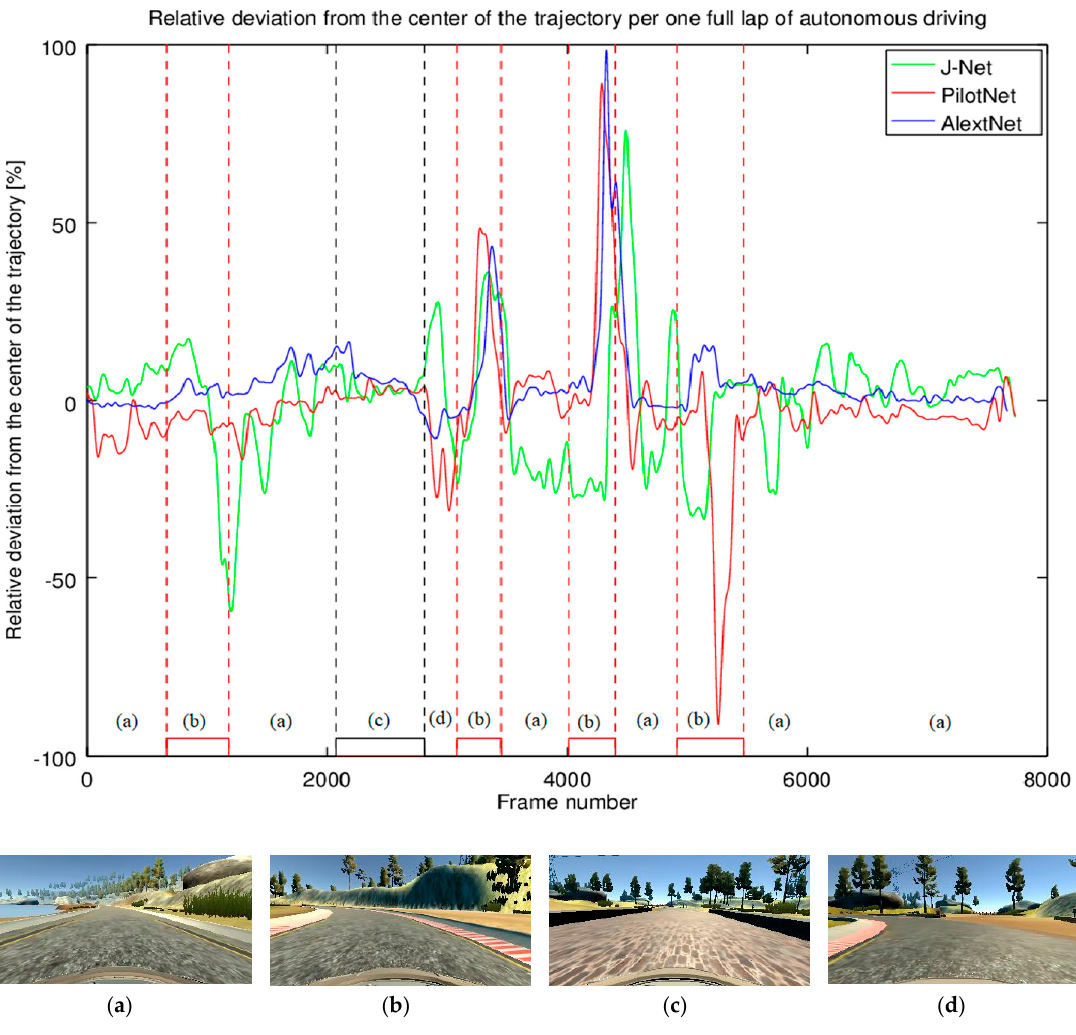
Figure 17. Relative deviation from the center of the trajectory per one full lap of autonomous driving. The four main characteristics of the trajectory are parts of the track defined with: ( a ) shoulders—regular, mostly straight road; ( b ) red and white stripe—mostly sharp curves; ( c ) a small wall—the bridge; ( d ) red and white stripe and dirt—a sharp curve.